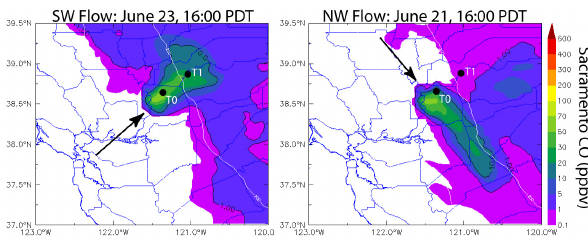
Fig. 3. Examples of tracer forecasts, based on CO emitted from Sacramento, shown at 16:00 PDT under southwesterly (left panel) and northwesterly wind (right panel) flow